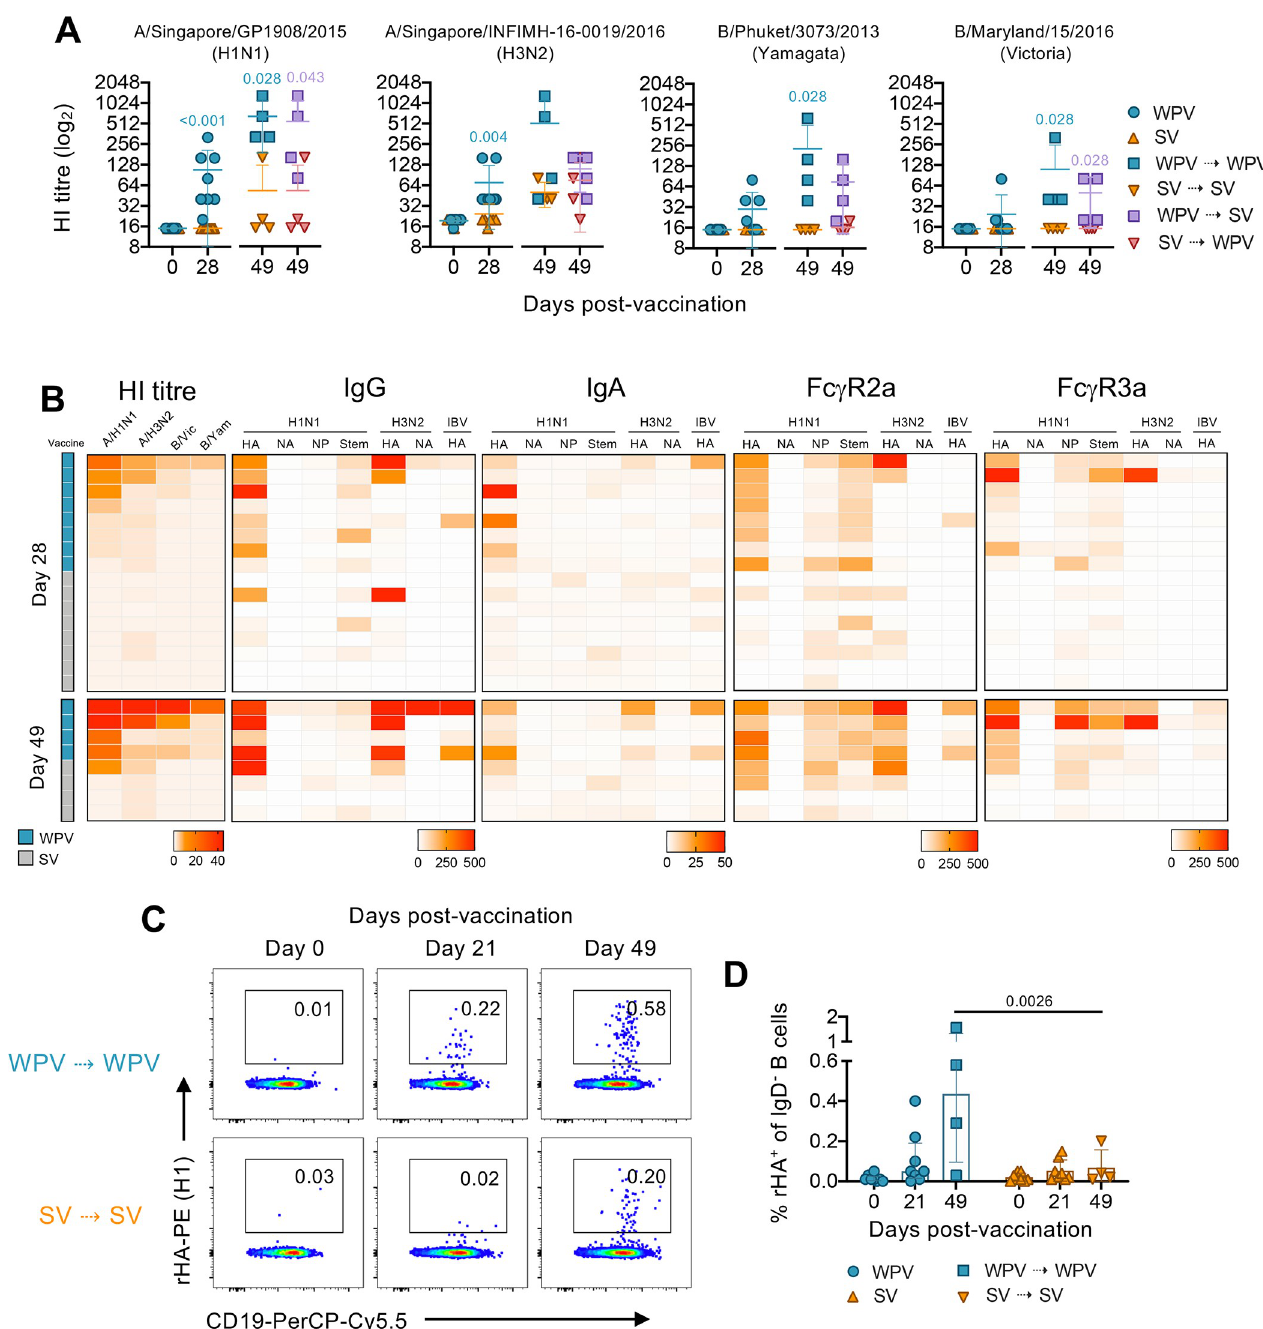
Fig 4. Increased HI titres induced by WPV are associated with superior antibody profiles and correlate with higher frequencies of antigen-specific B cells. (A) Plasma collected at each time point was assessed for HI against vaccine-matched H1N1, H3N2 and IBV strains. Individual HI antibody titres are depicted with the mean ± SD. (B) Heatmap of HI antibody titres and antibody levels of macaques after vaccination with one (day 28) or two doses (day 49) of the same formulation. Each row represents a different sample with their matched measurements in each column. (C) PBMCs isolated from macaques that were vaccinated with the same formulations were analysed for H1N1pdm09 virus-specific B cells. Shown are representative dot plots of rHA + CD19 + cells within class switched (IgD - ) B cells and (D) frequencies (%) of rHA + B cells within each group (mean ± SD). Statistical significance in (A) data comparing WPV and SV groups at each time point was assessed by Mann-Whitney tests and (D) data comparing both groups and time points with each other was determined by a two- way ANOVA with Tukey’s correction for multiple comparisons.